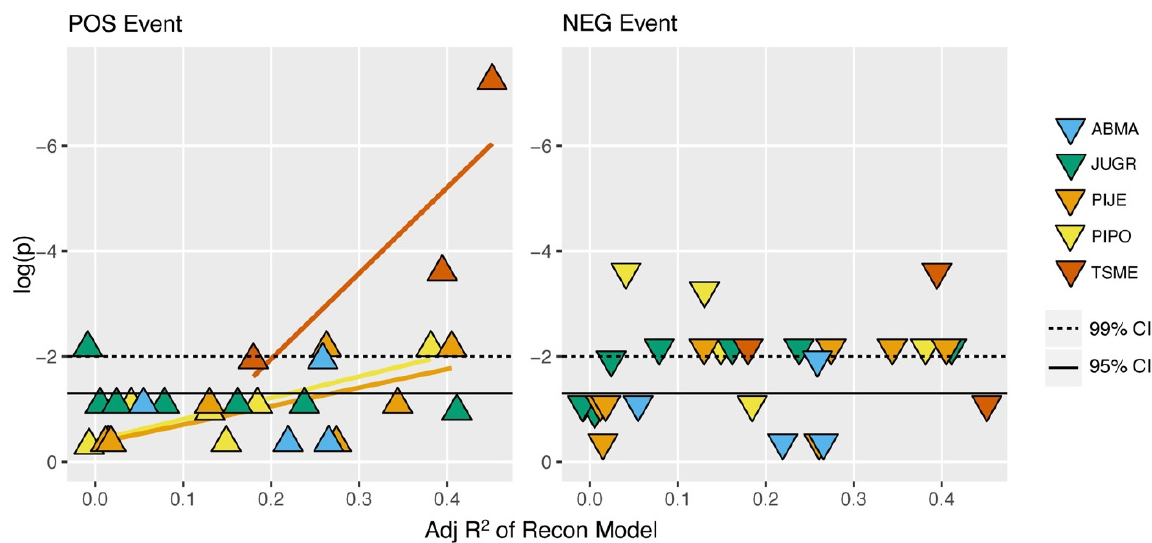
Figure 8. Event-matching significance as a function of R 2 of regression models for single-site reconstructions. Points, color-coded by species, represent p -values for the hypergeometric test of the number of matches of P12 whiplash events by events in reconstruction. Plotting convention as in Figure 4. Least-squares-fit lines shown only for sites grouped by species when the slope of the line is significantly different from zero at α = 0.05.